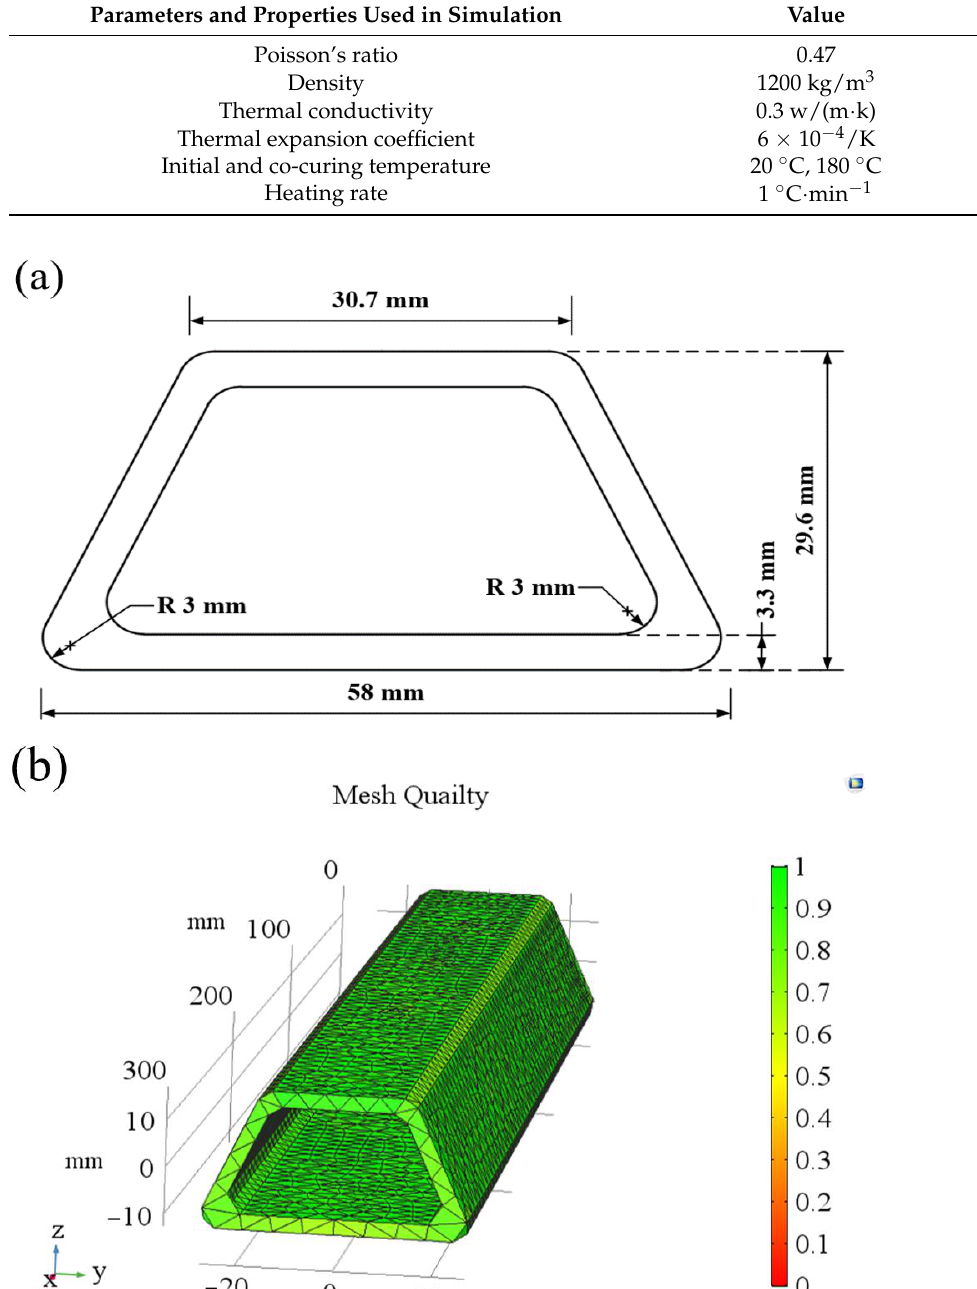
Figure 5. Thickness measurement positions of stringer-stiffened panel. In order to obtain more data, sectioning was performed for 6 times to obtain 12 sets of data. The sampling positions relative to the panel product line are shown in Figure 6 below.